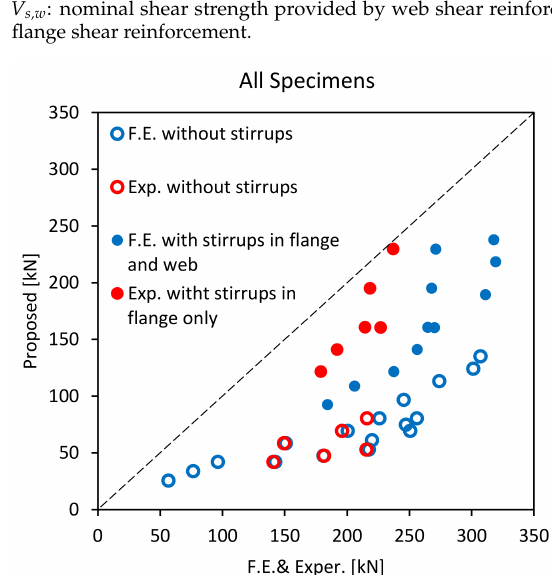
Figure 11. Correlation between the proposal, FE, and the experimental